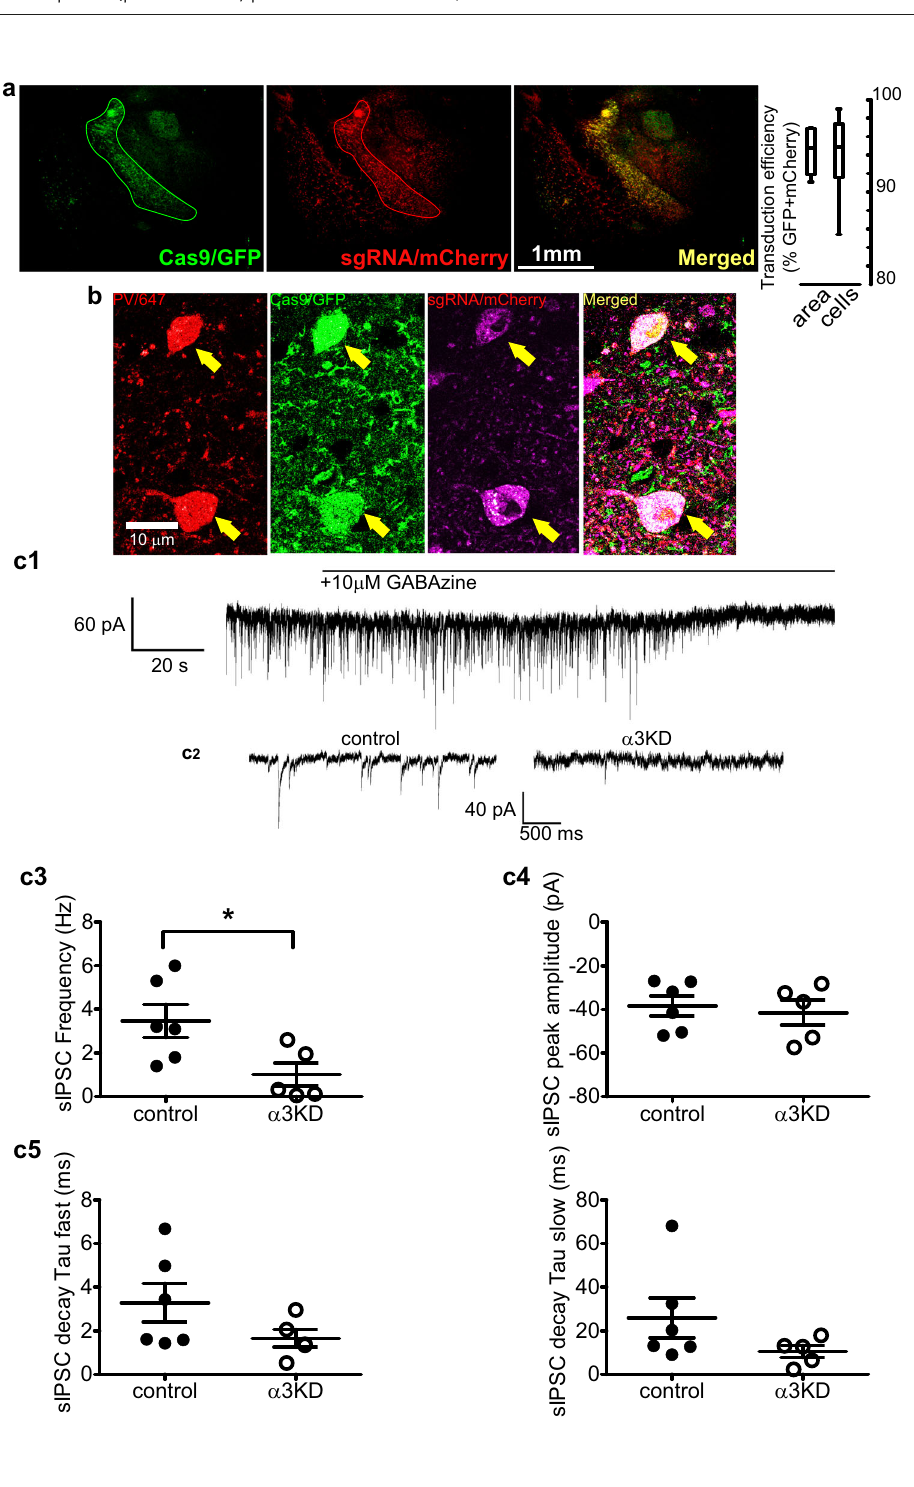
Fig. 3 α 3KD caused the largest delta ( δ , 1.5 – 4 Hz) effect in the longest NREM bouts before REM. a Analysis of non-rapid eye movement sleep (NREM) to rapid eye movement sleep (REM) transitions reveals larger delta power increases in longer NREM episodes, baseline (BL; blue) vs α 3KD (red). Periods with stable delta (black bars), were tested for signi fi cance (one-tailed paired t -tests, * p < 0.05, n.s. not signi fi cant; p -values: 0.023; 0.028; 0.041; 0.039; 0.082.). The 24 s prior to NREM-REM transitions, when delta decays, were not included in statistical analyses. b Percent change in NREM delta power was positively correlated with NREM bout length prior to REM. P values from t -tests (BL vs α 3KD) were negatively correlated with NREM bout length prior to REM as determined using Pearson ’ s linear correlation, two-tailed, ρ is Pearson ’ s linear correlation coef fi cient. Data from 12 h light period. N = 6. Color scales represent normalized power (power at time/power from